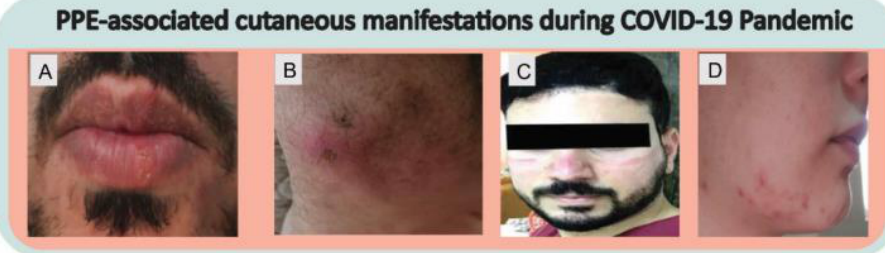
Figure 5. Documented cases of personal protective equipment (PPE) associated skin rashes during the pandemic; ( A ) Herpes simplex reactivation triggered by friction caused by wearing a surgical mask, ( B ) gown-related contact urticaria, ( C ) impressions on the face, ( D ) mask-related frictional acne. Adapted with permission from [75,86]